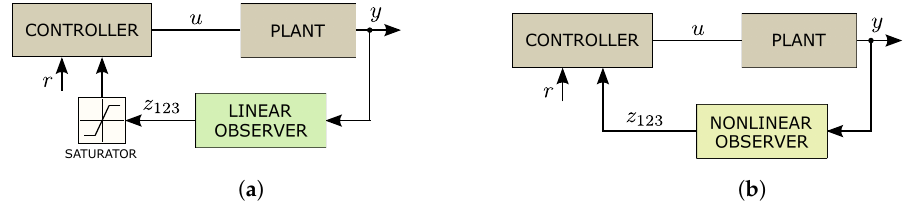
Figure 9. Block diagrams of the implemented controllers. ( a ) Linear ADRC. ( b ) Nonlinear